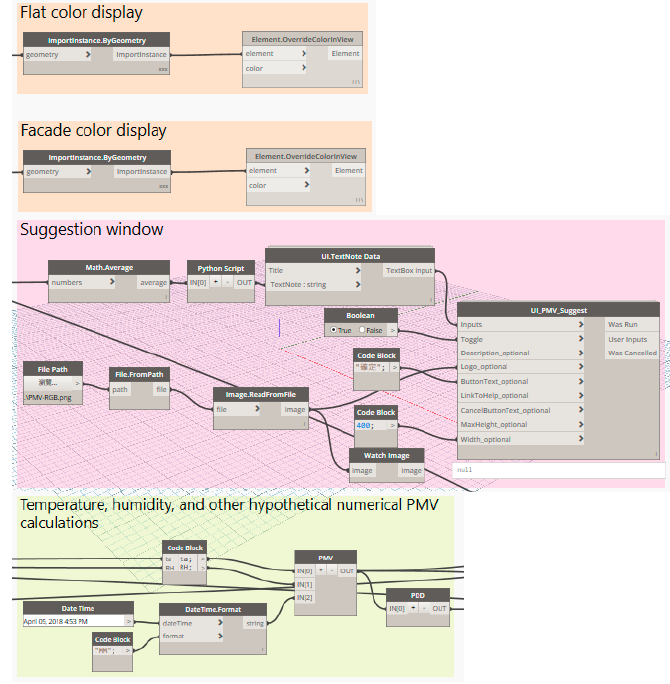
Figure 11. PMV analysis and improvement suggestions.